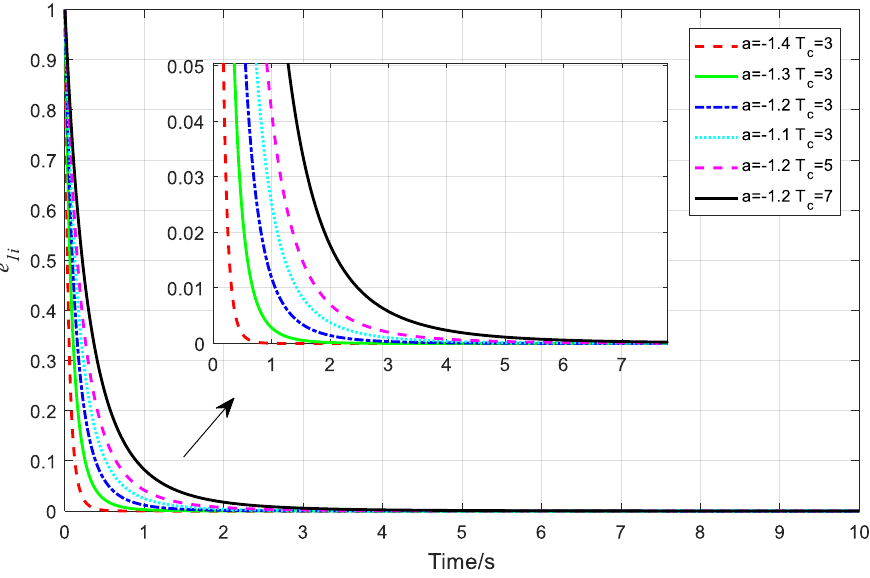
Figure 4. The simulation results of the tracking errors.